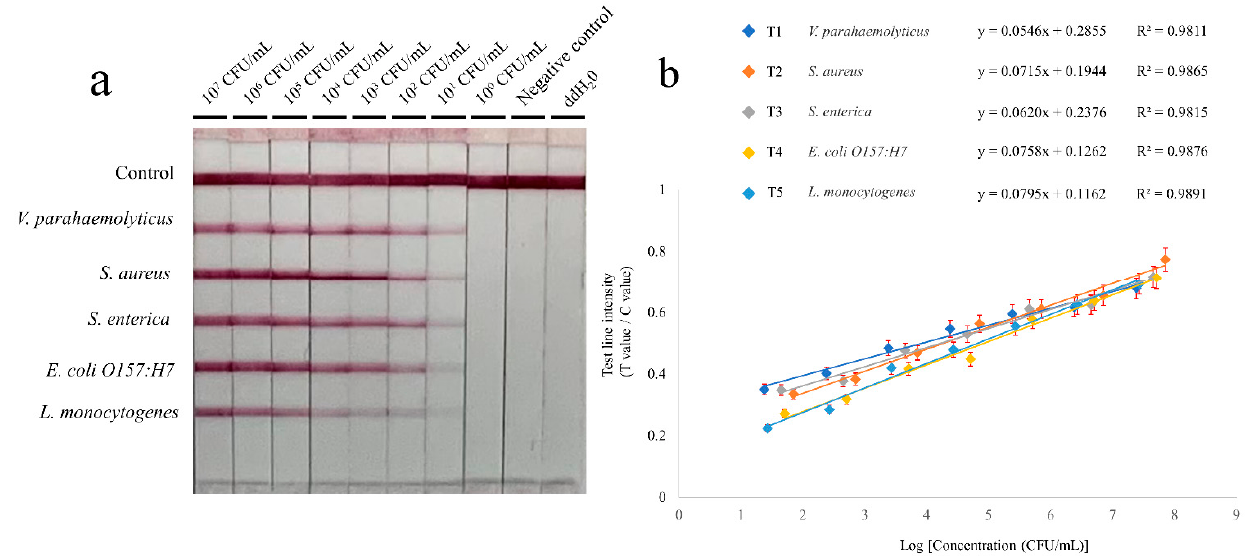
Figure 3. Reaction sensitivity of the RPA-LFIA. ( a ) Amplification results. The initial concentration of V. parahaemolyticus , S. aureus , S. enterica , E. coli O157:H7 , and L. monocytogenes were 2.4 × 10 7 CFU/mL, 7.1 × 10 7 CFU/mL, 4.5 × 10 7 CFU/mL, 5.1 × 10 7 CFU/mL, and 2.7 × 10 7 CFU/mL, respectively.